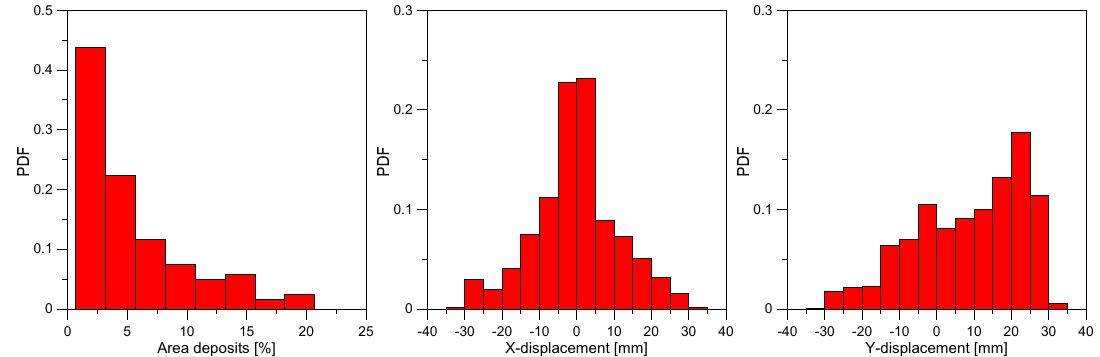
Figure 3. PDF of the area and x-y displacement of the centroid calculated for SOI300 with gasoline fueling.